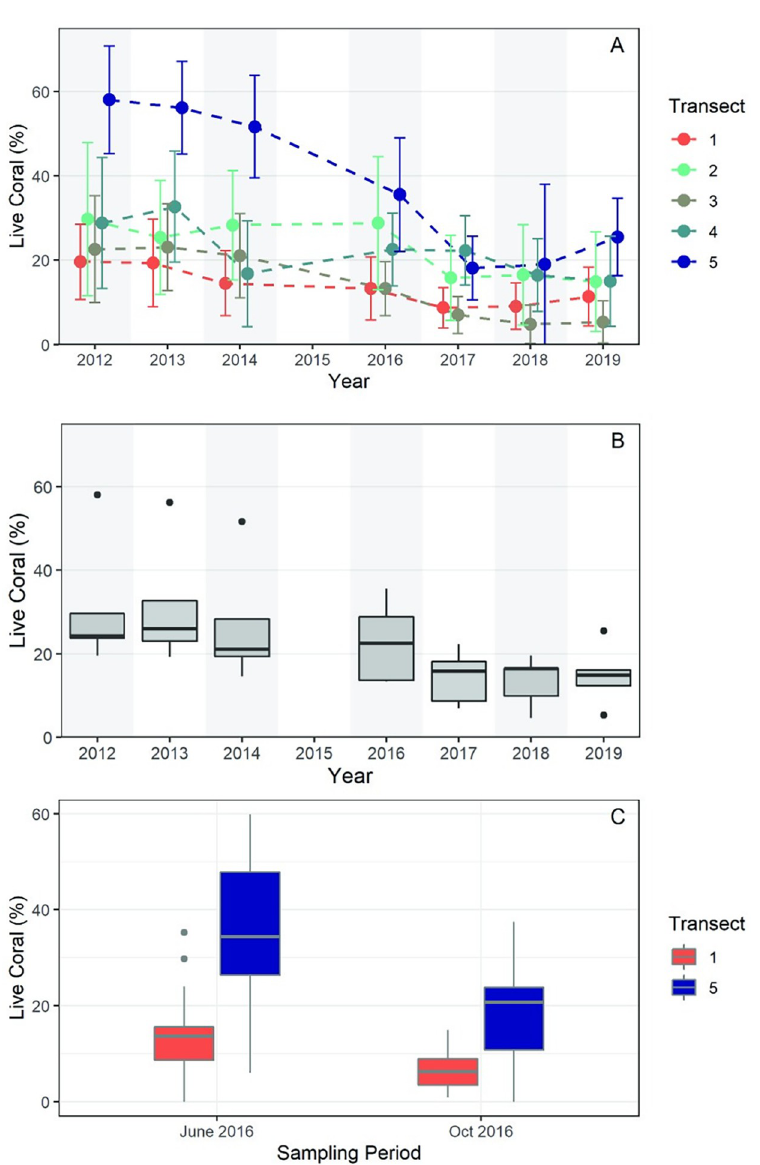
Fig 3. Summary of mean live coral per 1 m 2 at each Coral Gardens transect site from 2012–2019. (A) Mean percent live coral per year per transect with 1-sigma errors; (B) Boxplot of live coral percentage as an average of the five equally weighted transects shown by year. Shaded rectangles indicate the interquartile range, whiskers indicate minimum and maximum values, the thick horizontal lines are at median values, and filled circles are statistical outliers; (C) Boxplot of live coral at Transects 1 and 5 in June and October of 2016. Symbols as in 3B. A and B do not include October 2016